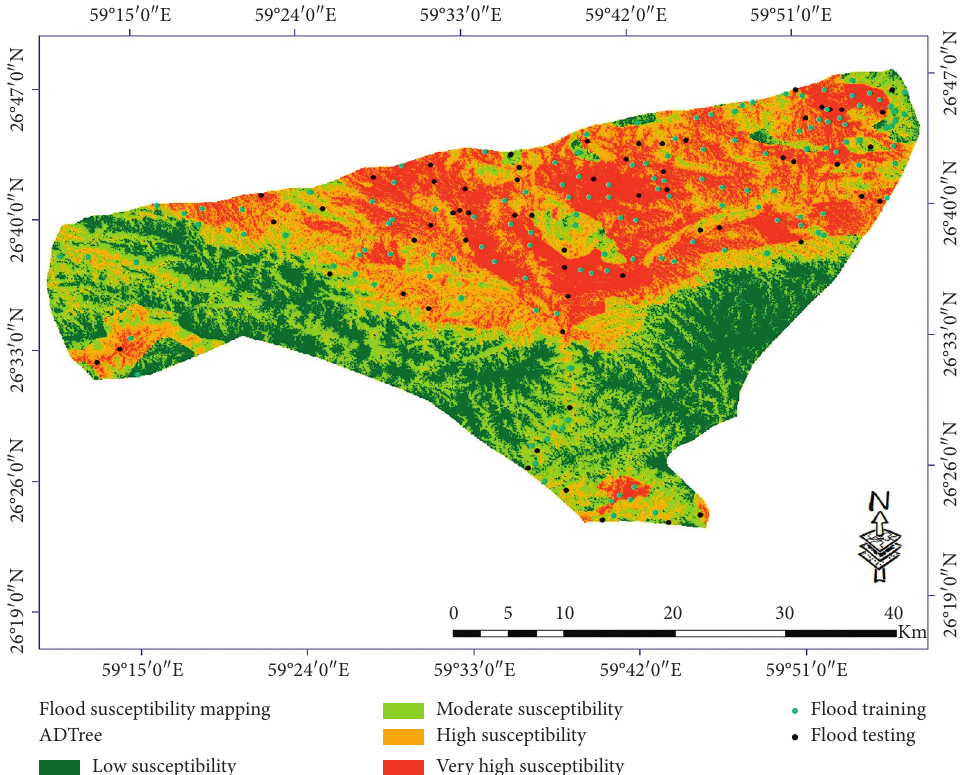
Figure 16: Flood susceptibility map derived from ADTree